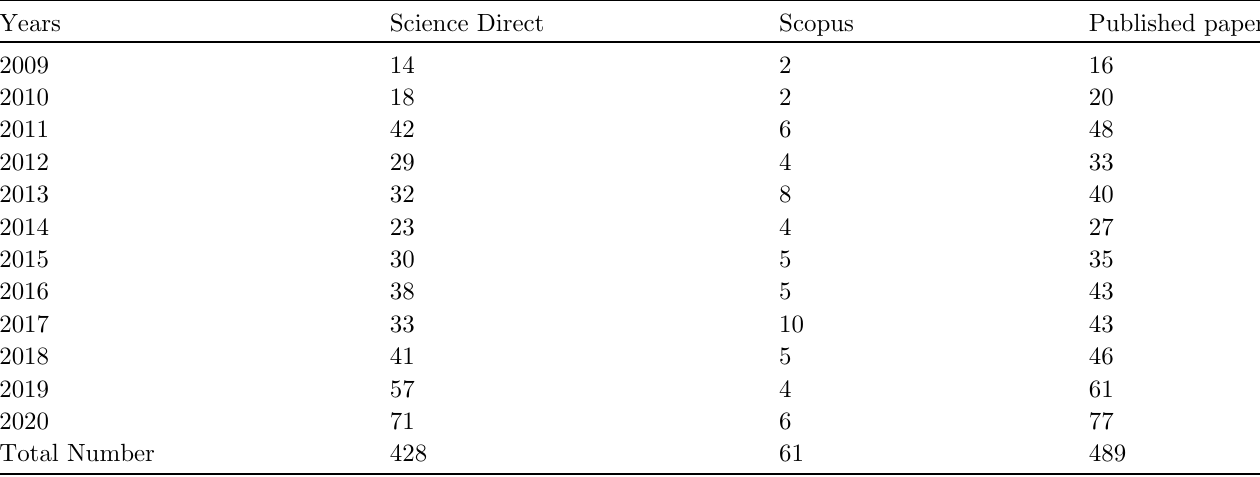
Fig. 2. Paper ’ s contribution in each research topic. Table 3. Biohydrogen production via biophotolysis ’ bibliographic results.